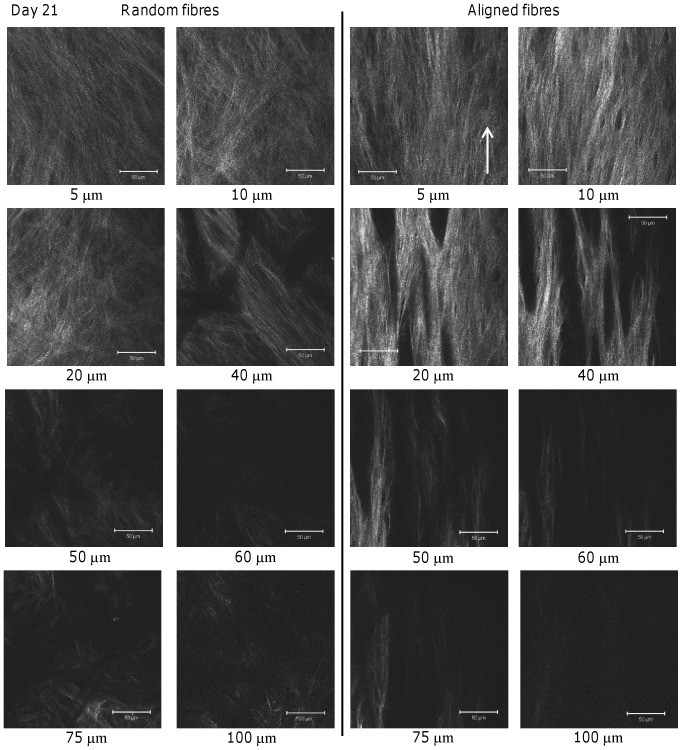
Collagen SHG of HDF-seeded constructs at day 21.SHG images of collagen matrix deposited on random and aligned scaffolds were obtained at day 21 at different depths. SHG intensity and area coverage is greater at all depths than the equivalent depths at day 14 suggesting increased collagen deposition and organisation. For images taken at 75–100 µm on both scaffolds, laser power was set to maximum in order to see any SHG present. Arrow indicates direction of scaffold fibre alignment. Scale bars are 50 µm.